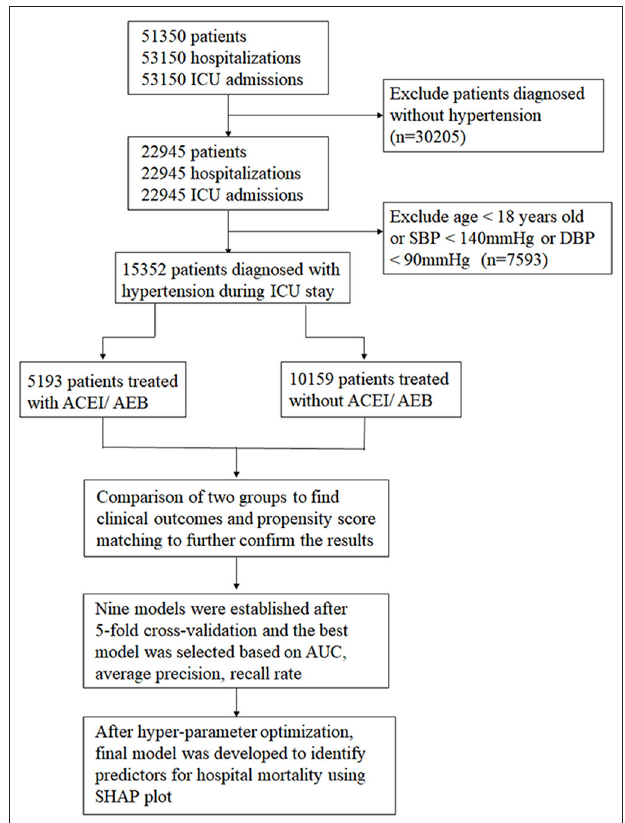
FIGURE 1 | Study protocol